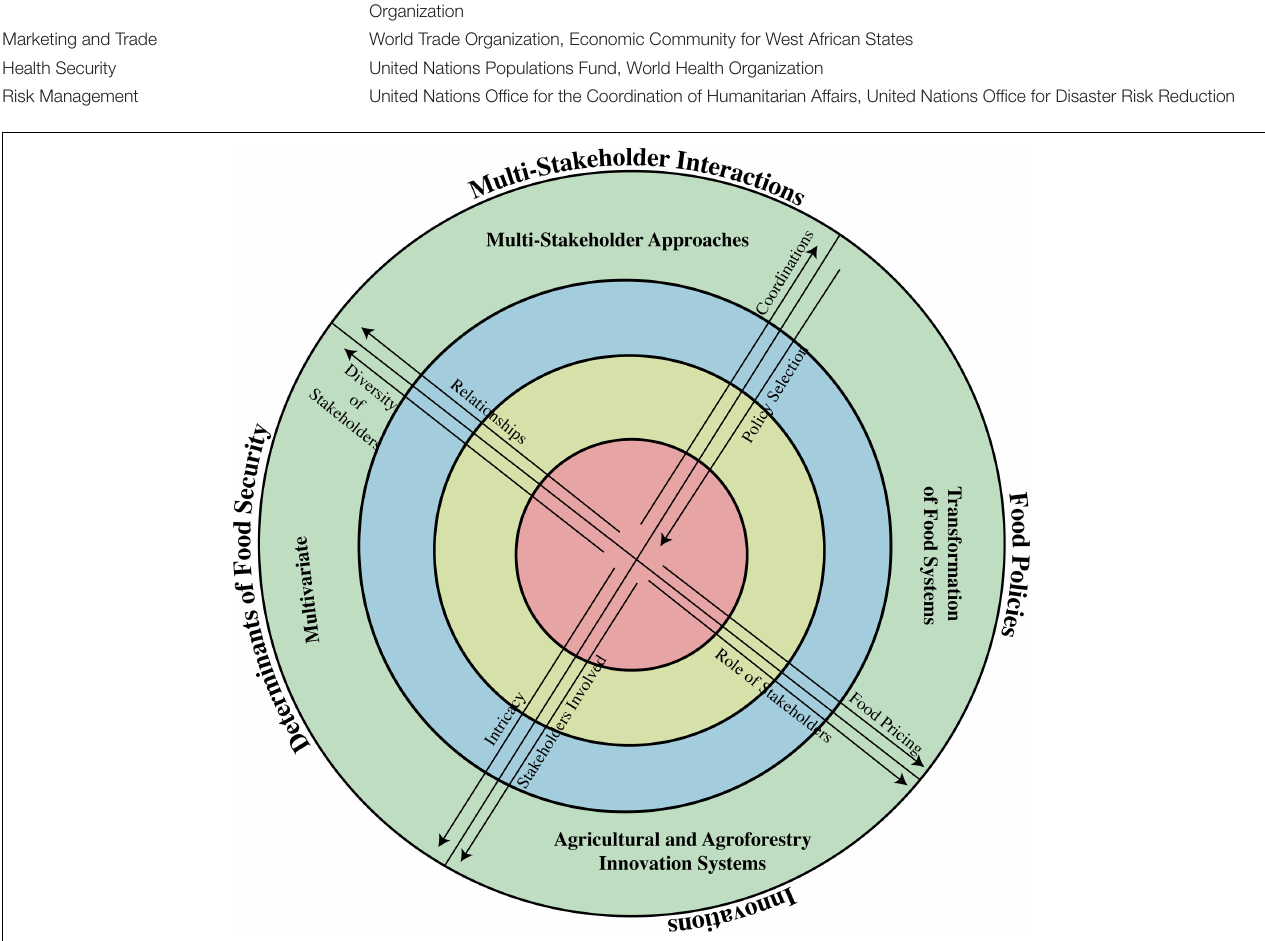
FIGURE 8 | Importance of interlinked multi-stakeholder interactions to better address the food security